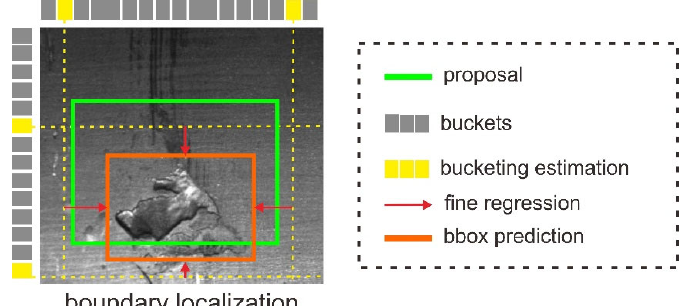
Figure 6. Visualization of Side Aware Boundary Localization (SABL). To replace the proposal: the bucketing estimation is used to predict the buckets candidate and employs the fine regression to acquire the final bounding box (bbox) prediction.